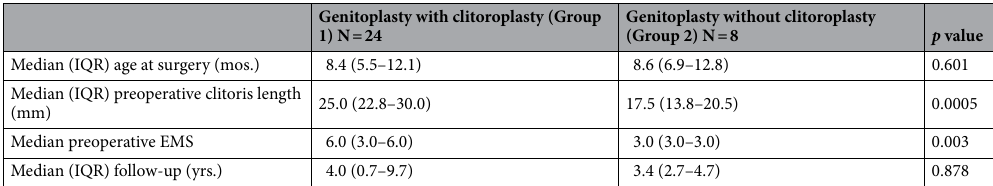
Table 1. Descriptive characteristics of the cohort. EMS external masculinization score, IQR interquartile, mm millimeter, mos. Months, N number, yrs.